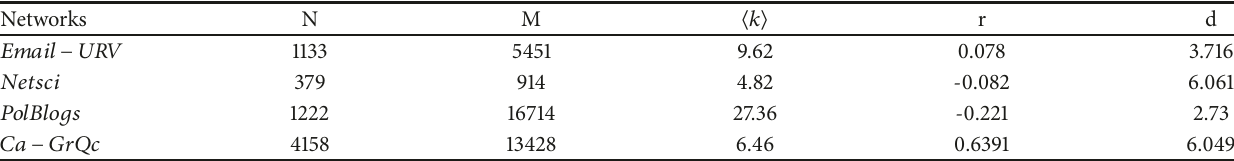
Table 1: Structure properties of the real social networks. Structure properties include the number of nodes 𝑁 , the number of edges 𝑀 , the average degree ⟨𝑘⟩ , the assortative coefficient 𝑟 , and the average shortest path length 𝑑 .